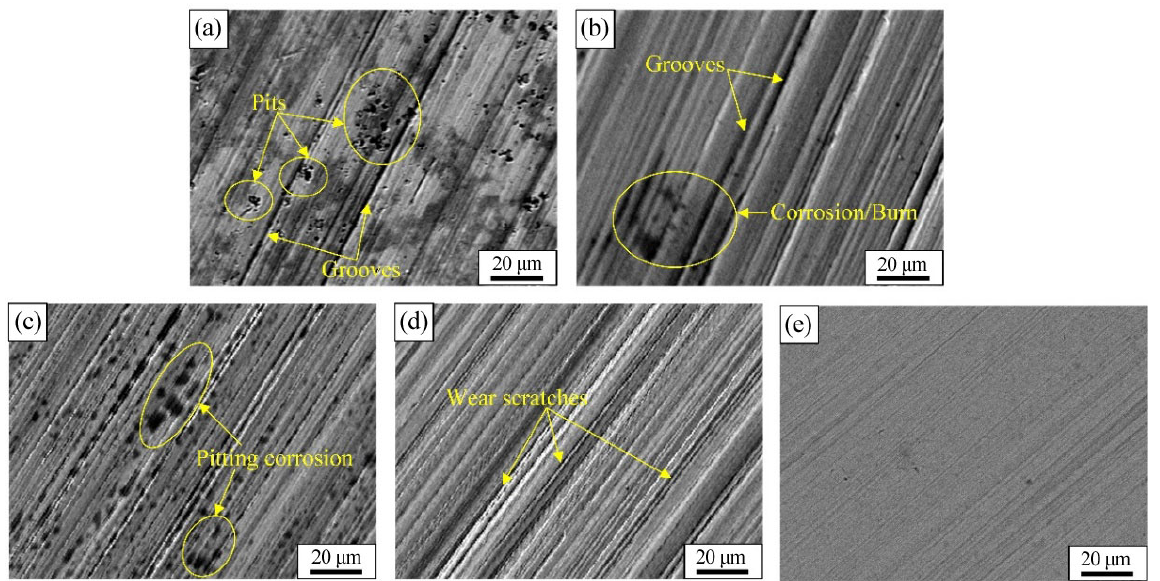
Fig. 15 SEM images of bearing raceways. (a) Non-textured, (b) dimple, (c) groove, (d) gradient groove, and (e)